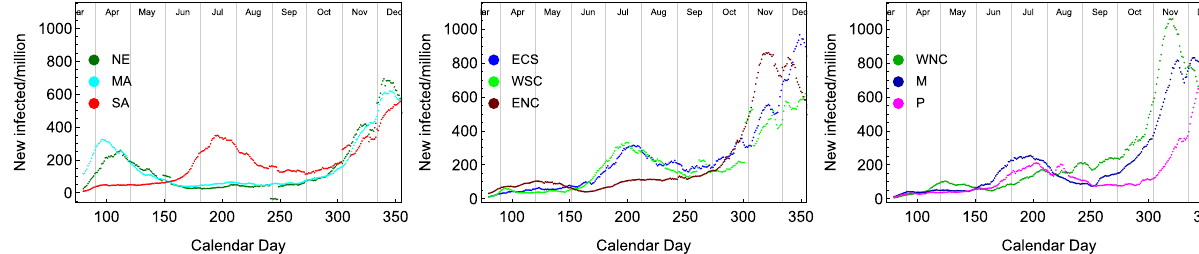
Figure 2. Weekly new number of cases for all the 9 divisions.